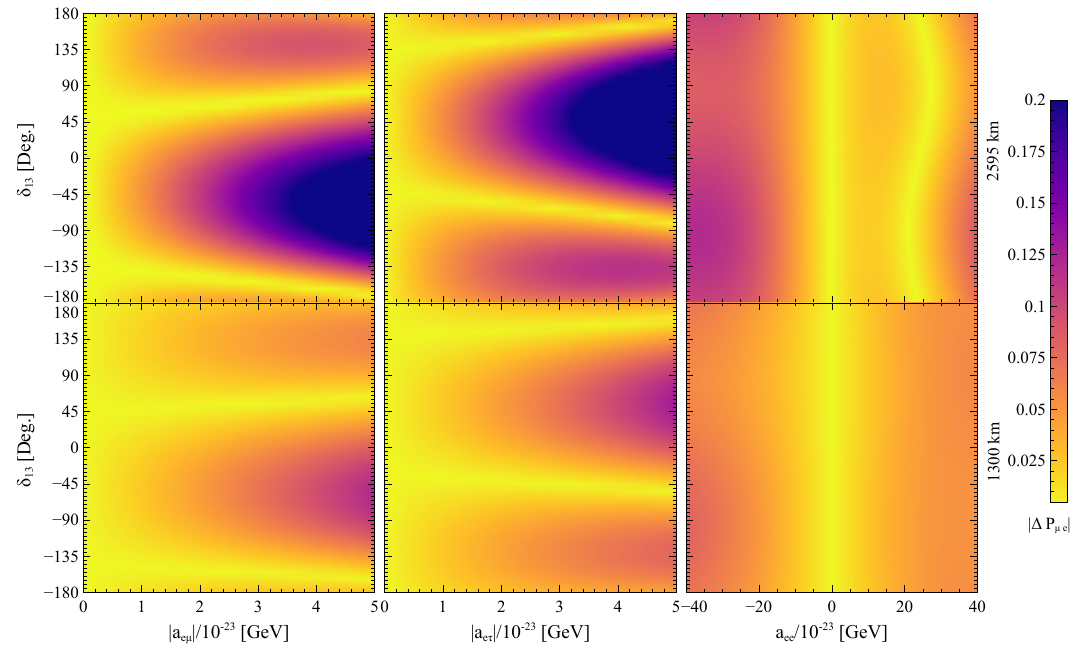
Figure 2 . We plot the heatplot for | ∆ P µe | = | P µe ( SI+LIV ) − P µe ( SI ) | for the P2O baseline of 2595 km (top row) and for DUNE baseline of 1300 km (bottom row). The plots were done for the respective values of energies roughly corresponding to first oscillation maximum: 2.5 GeV for DUNE and 5 GeV for P2O. The heatplot is shown as a function of the three LIV parameters ( | a eµ | , | a eτ | , a ee ) along the horizontal axes and the standard (Dirac) CP phase δ 13